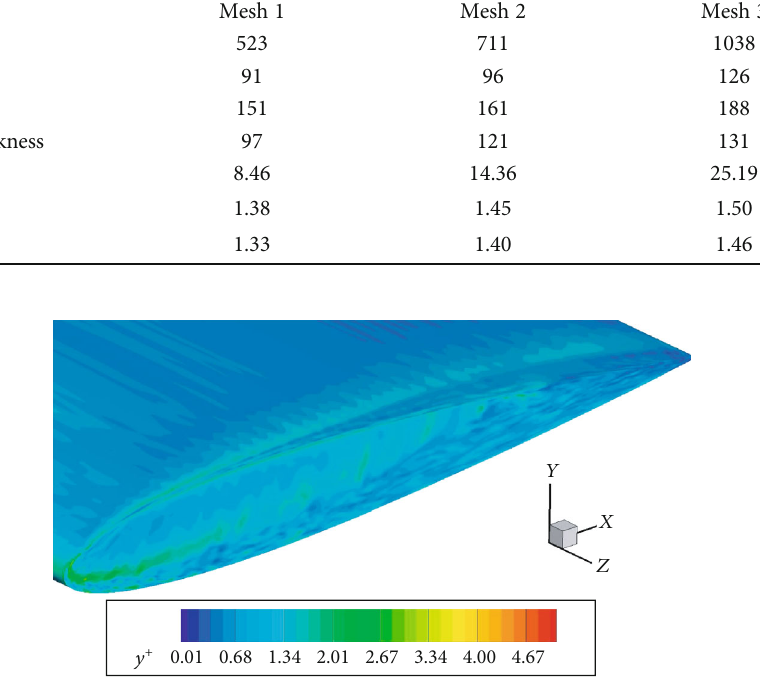
Figure 4: The distribution of y + near the wingtip of case